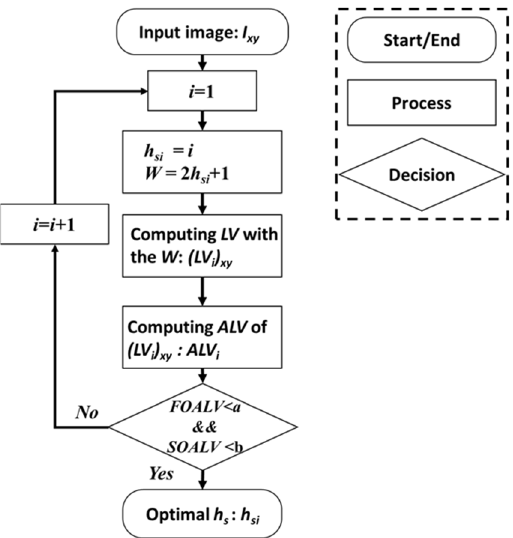
Figure 5. The workflow of selecting the optimal h s value for the mean shift algorithm. Based on the selected h s value, the h r and h t values can be further calculated as the average local standard deviations of the spectral layer and texture layer within the W , respectively, as shown in Equation